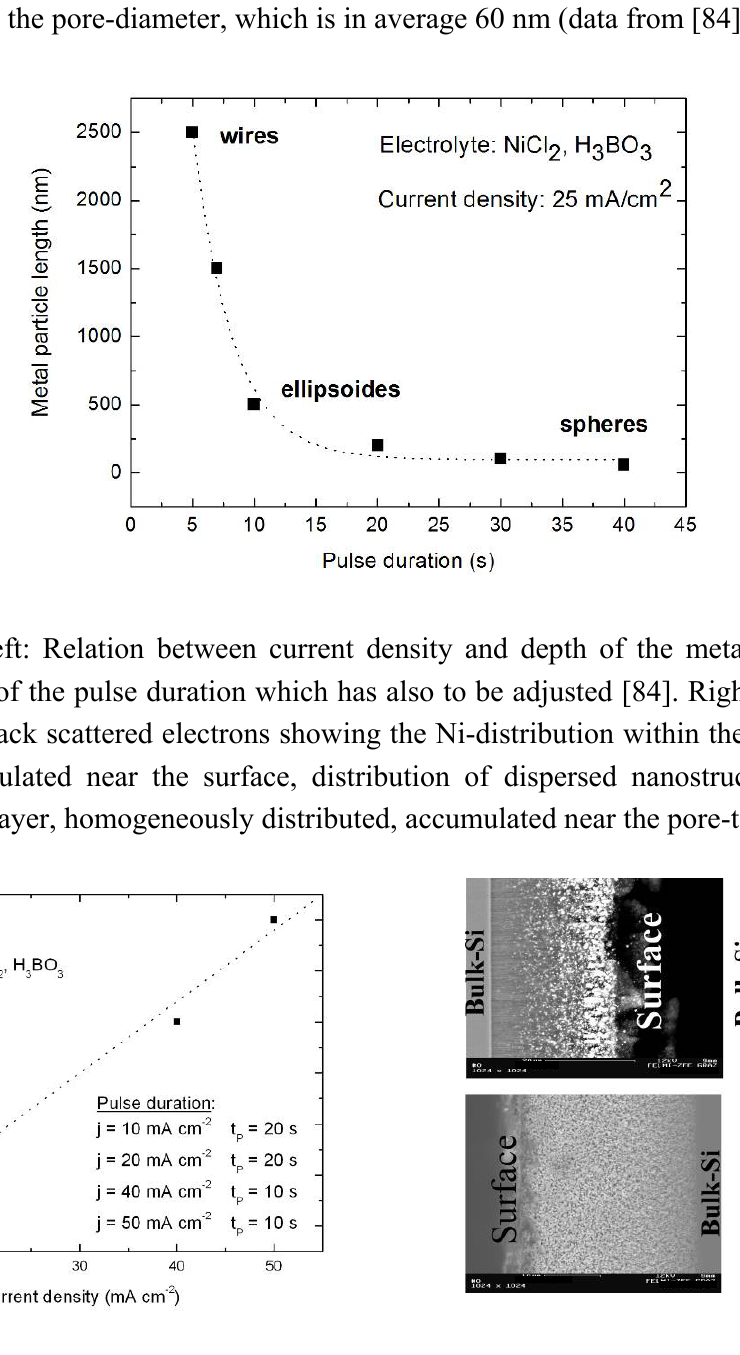
Figure 20. Relation between pulse duration of the applied current and elongation of the precipitated Ni-structures. The deposition time is in all cases 15 min and the applied current density was 25 mA/cm 2 . The length of the particles increases from sphere-like particles of about 60 nm up to wires of 2.5 µm. The diameter of the metal structures corresponds to the pore-diameter, which is in average 60 nm (data from [84]).